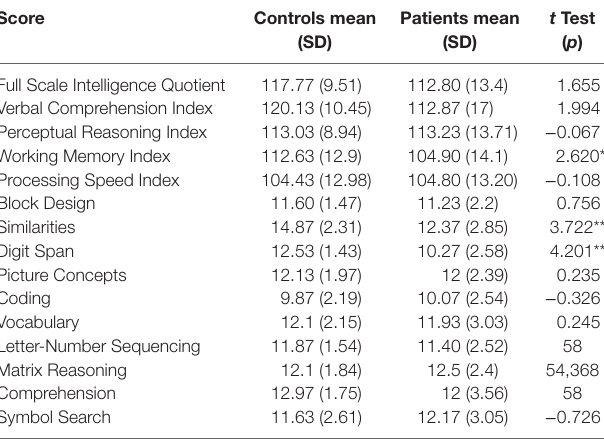
Table 1 | Comparison of Wechsler Intelligence Scale for Children—IV edition scores in subjects with headache and controls. score controls mean